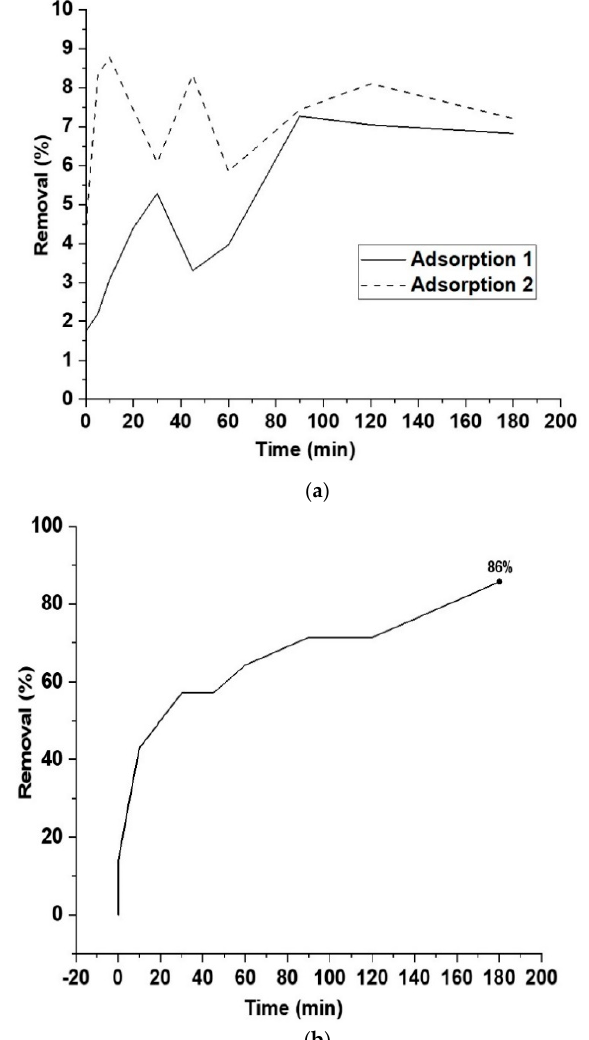
Figure 10. ( a ) Adsorption of diclofenac on fresh HCP25 (Adsorption 1) and regenerated material (Adsorption 2). Adsorption time (in dark) 180 min and ( b ) degradation of desorbed diclofenac during the HCP25 regeneration under UV-B irradiation (180 min).